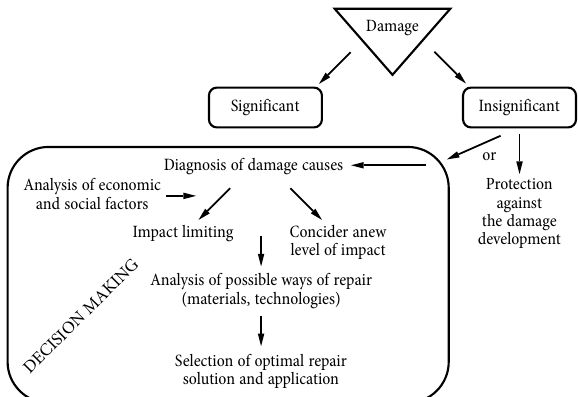
Fig. 3. The simplified repair algorithm (Czarnecki, Emmons